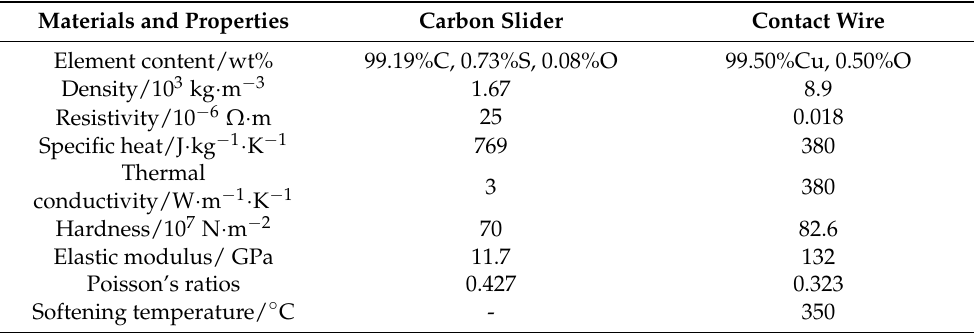
Table 1. Chemical composition and physical properties of the experimental material. Materials and